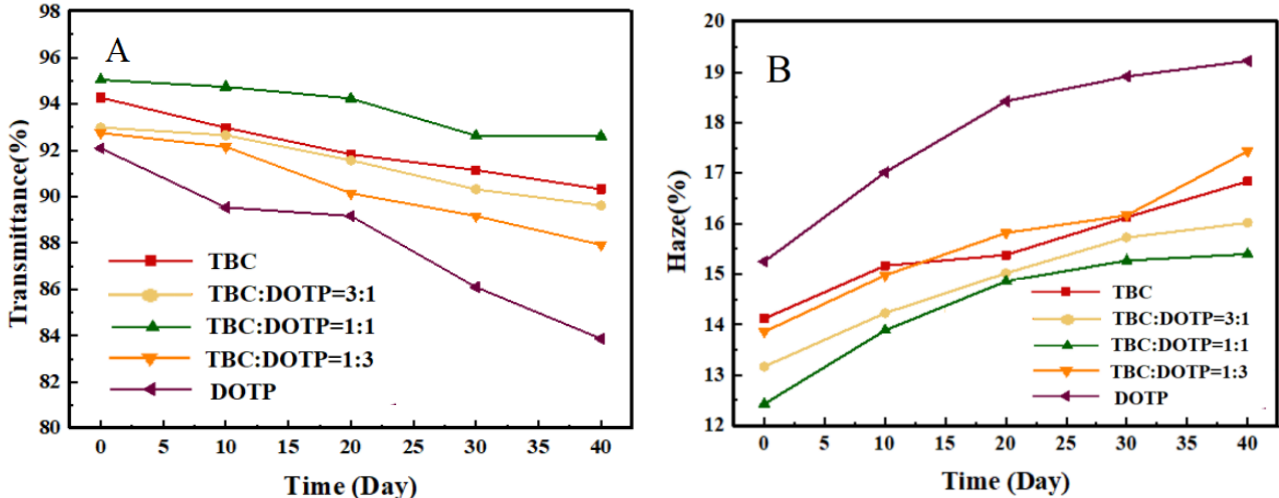
Figure 15. The average transmittance at 550–800 nm ( A ) and haze ( B ) versus time of PVC with Zn(Arg) 2 plasticized by TBC and DOTP in different proportions.